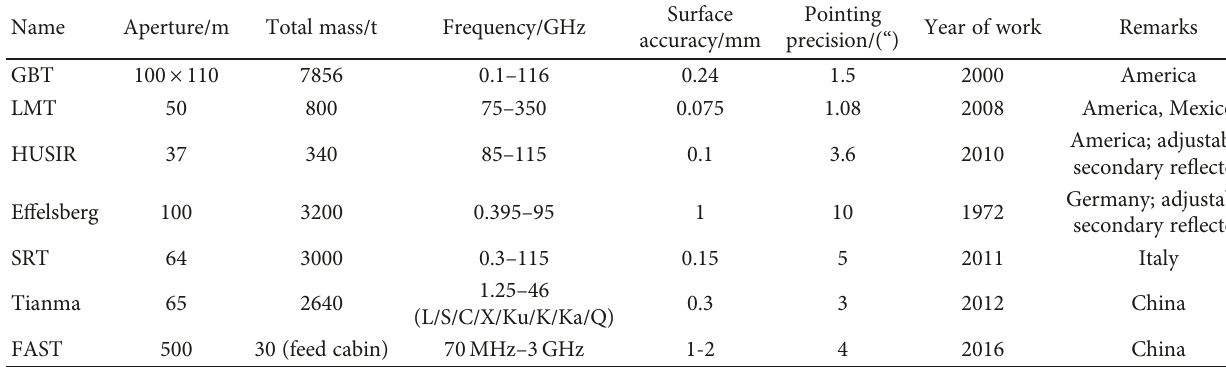
Table 3: Typical radio telescopes with active surface.